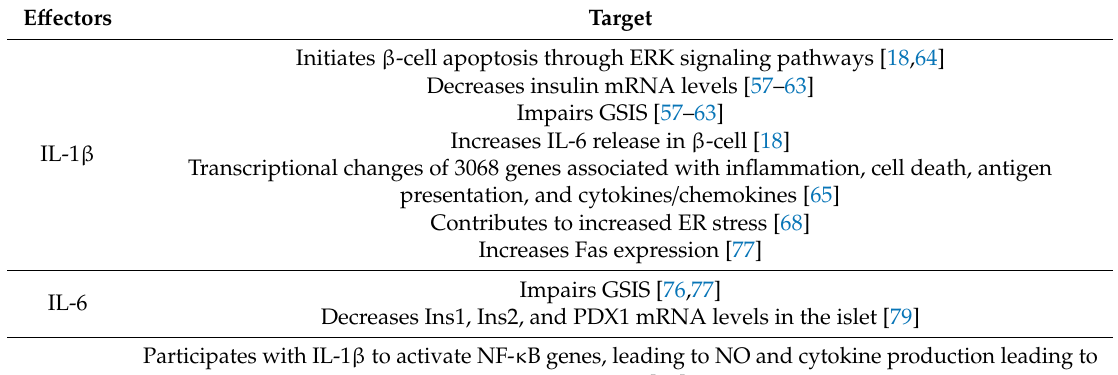
Table 1. Macrophages secreted factors that have a negative e ff ect on functional β -cell